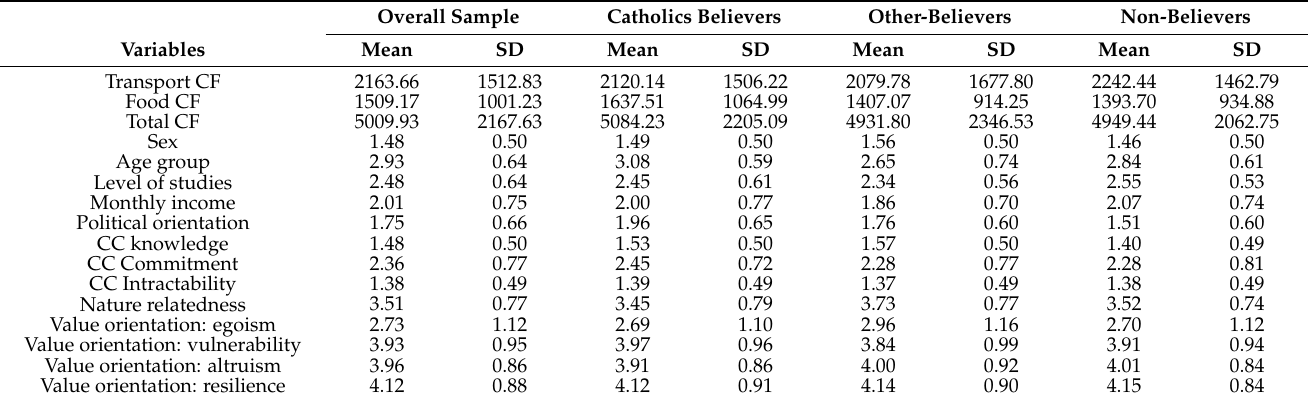
Table A3. Descriptive statistics for the overall sample and each religious group.